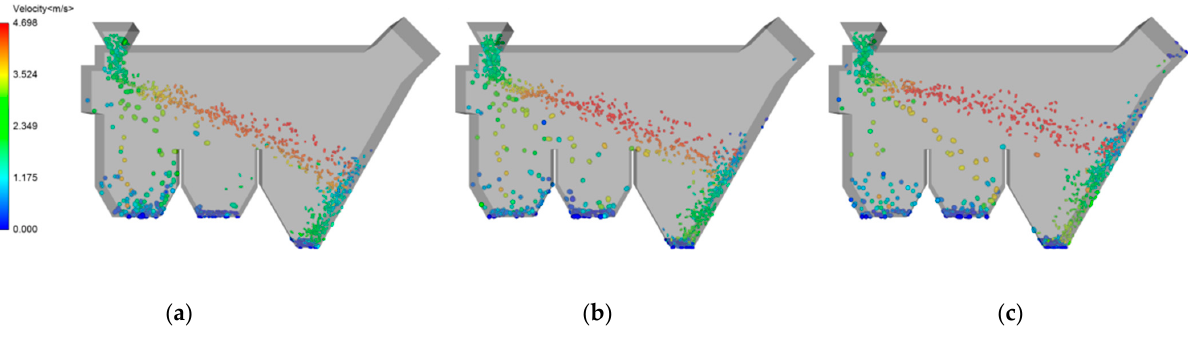
Figure 16. Particle motion of different inlet airflow velocity: ( a ) 7 m/s; ( b ) 8 m/s; ( c ) 9 m/s. According to the analysis of Figure 16, when the inlet airflow speed is adjusted to 7 m/s, the wind power is weak. Due to the large specific gravity of stones and filaments, under the action of airflow, the resultant force is downward, and most of them settle at outlet 1. Very small amounts of petals and stones are brought to outlet 3, and the impurity rate is low. Under weak wind, the speed of the filament is lower, and part of the filament falls at outlet 2, resulting in an increase in the loss rate. The increase in the inlet airflow velocity leads to an increase in the dust remover velocity, which causes part of the safflower petals to move to the dust remover under the action of the airflow. It was found from the observation of the particle motion trajectory that the bonded petals and the stones began to gather towards outlet 2 and outlet 3 when the inlet airflow velocity increased, which led to an increase in the impurity rate. By comparing Figures 15 and 16, the airflow inclined angle has little effect on the flow field but has a great influence on the particle movement and separation effect. Figure 17 shows that the axial average velocity of each component of the mixture increases with increasing airflow inclination angle. The axial average velocity of the safflower petals is greater than that of the bonded petals and stones, and the axial speed of safflower petals increases obviously with increasing inlet airflow velocity.